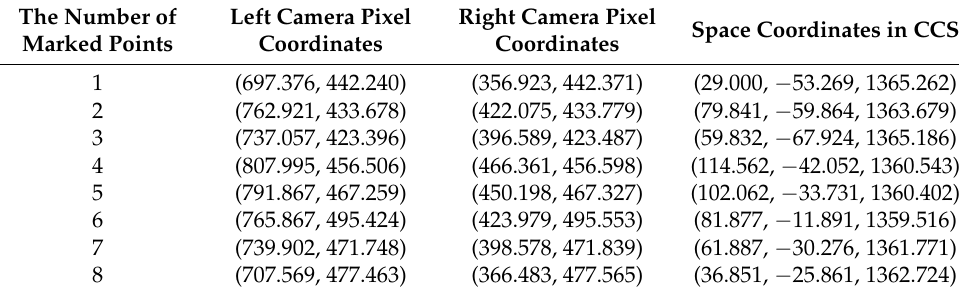
Figure 9. The matching result of the left image and the right image at a certain moment. Table 2. The coordinate value of the marked points at a certain time.